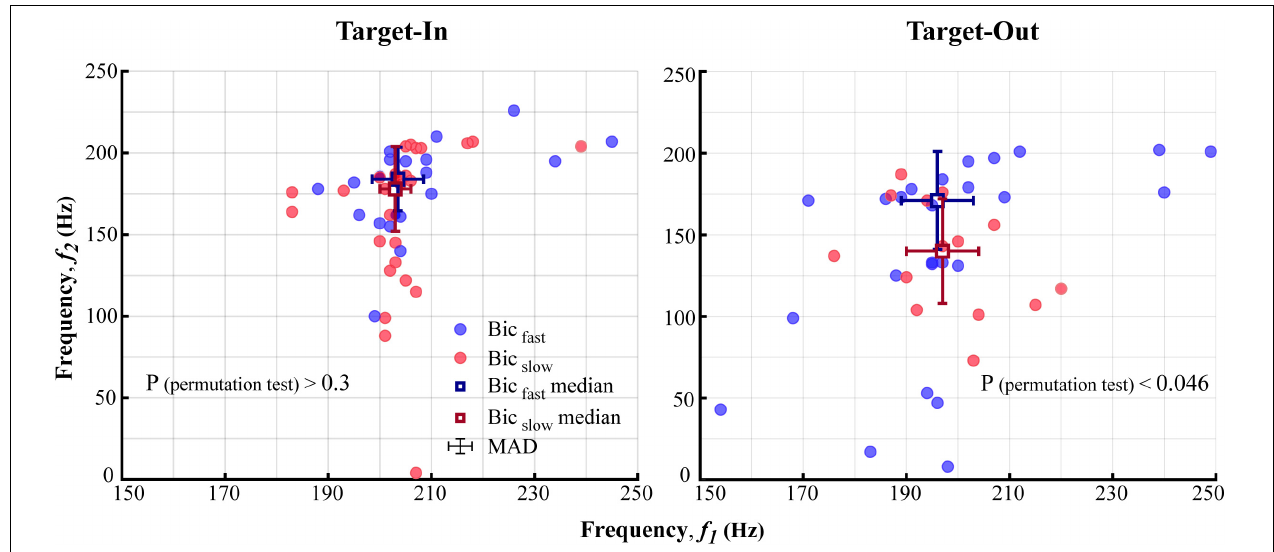
FIGURE 5 | The characteristic bifrequency of QPC in fast and slow trials for each target position condition (Target-In\Target-Out). The blue (Bic fast ) and the red (Bic slow ) circles show the bifrequency components in which the average bicoherence was larger in fast rather than slow trials, and vice versa, respectively. Blue and red squares represent medians of Bic fast and Bic slow groups, respectively. Error-bars demonstrate the median absolute deviation (MAD) calculated for each frequency axis. Distributions of the bifrequency component in Bic fast and Bic slow groups are significantly different in the Target-Out condition ( p < 0.046; using a permutation test). This is not the case for the Target-In condition ( p > 0.3, using a permutation test).